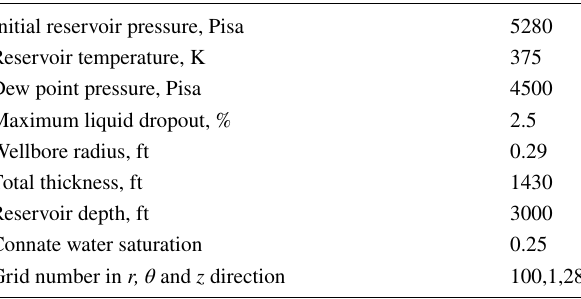
Fig. 2 Gas/oil relative permeability curves Table 3 Conditions of the base constructed reservoir